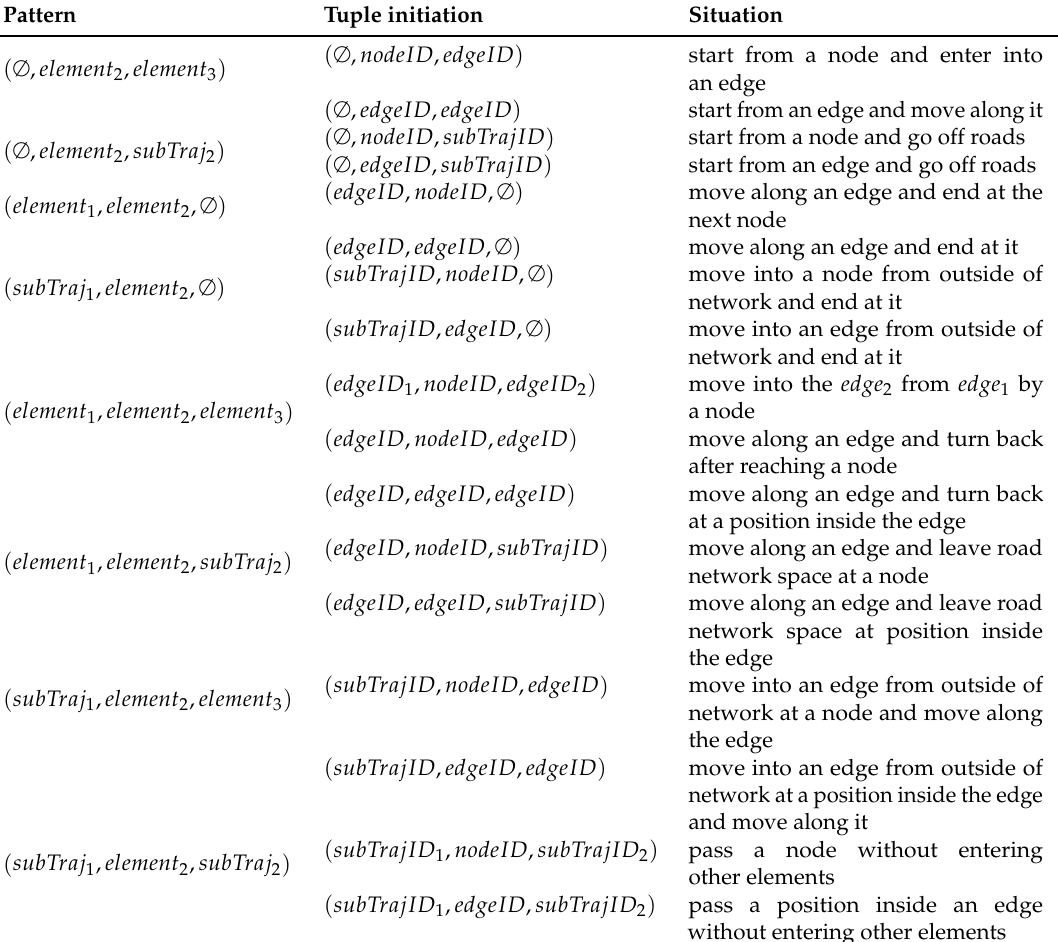
Table 1. Seventeen situations for trajectory-element